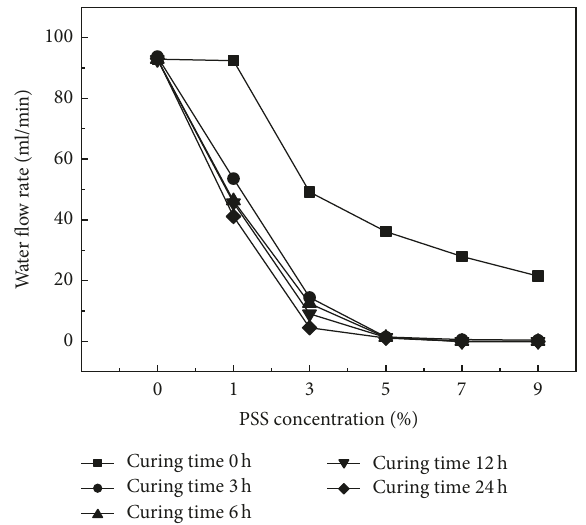
Figure 9: Variations of water flow rate ( 𝐹 ) of specimens with PSS concentrations at flow time of 12–15min.